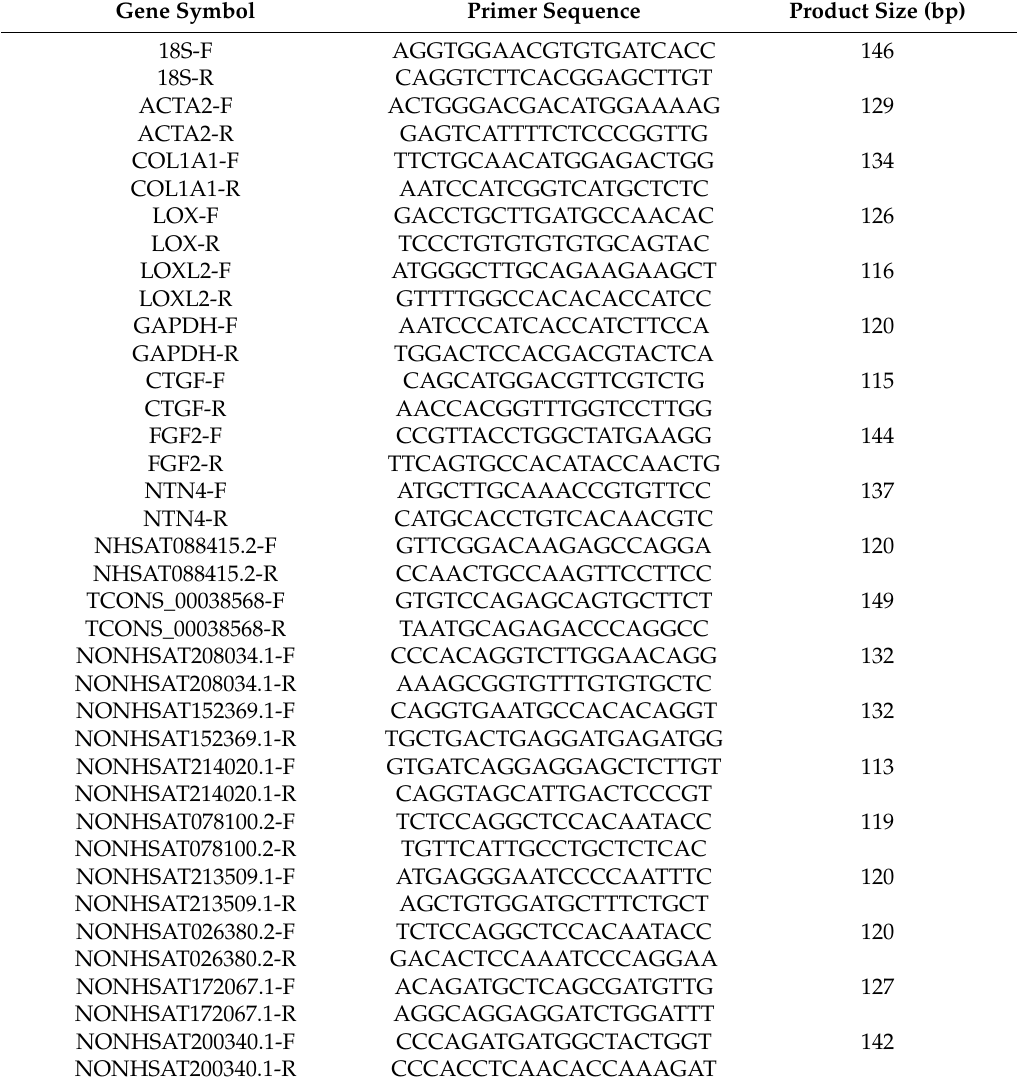
Table 3. The primer sequences used in this